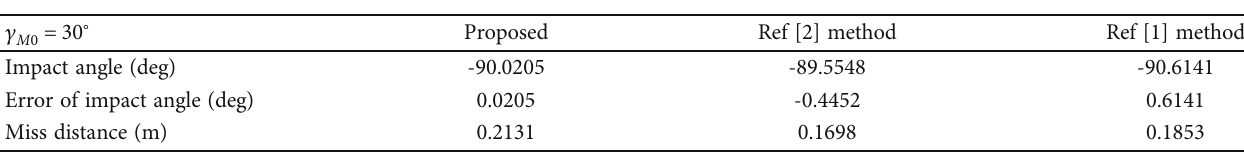
Table 5: Simulation result for Case II.